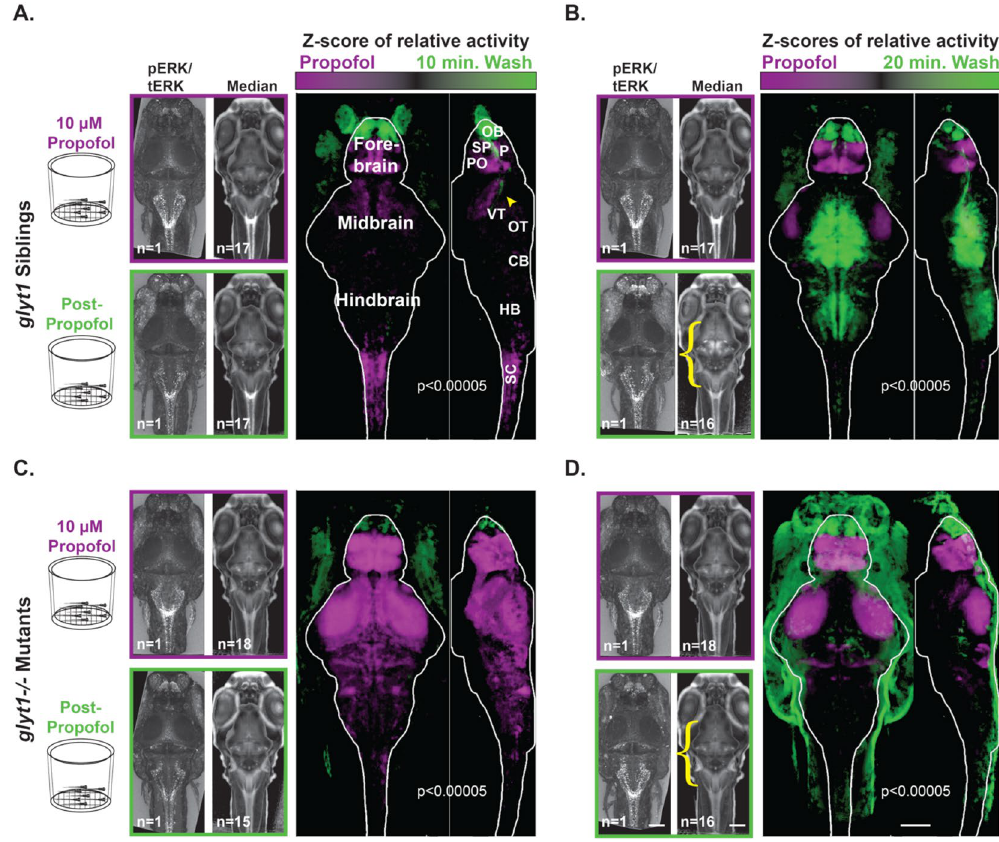
Figure 6. Compared to glyt1 siblings, glyt1−/− mutants show delayed activation of pre-motor, and motor regions during emergence from propofol. Four batches of sixteen to eighteen, six-day-old larvae were placed in baskets (diagramed to the left) to enable easy transfer of animals from 10 µM propofol to system water solutions. Half contained glyt1 siblings after ( A ) ten minutes and ( B ) twenty minutes in system water. The other half contained glyt1−/− mutants after ( C ) ten minutes and ( D ) twenty minutes in system water. To compare activity between propofol and wash treatments, voxels with more intense pERK/tERK at a p < 0.00005 threshold under propofol conditions are shown in purple while voxels with more intense pERK/tERK in system water during emergence are shown in green for glyt1 siblings ( A , B ) and glyt1−/− mutants in ( C , D ). glyt1 siblings show greater activation of preoptic, subpallium, and spinal cord regions under propofol, with the olfactory bulb and a regions of the diencephalon that encompasses the arousal pathways (yellow arrowhead in A ) being the first brain region to become more active during emergence from propofol, followed ten minutes later by the optic tectum, cerebellum and hindbrain. glyt1−/− mutants have greater activation of preoptic and subpallium, but also optic tectum neuropil and cerebellar neuropil under propofol. As with their glyt1 siblings, the olfactory bulb is the first brain region to become activated but there is no activation of other sensory, pre-motor, and motor regions by the twenty-minute timepoint consistent with delays seen in glyt1−/− mutants recovery of locomotor behaviors after propofol. Scale bars = 100